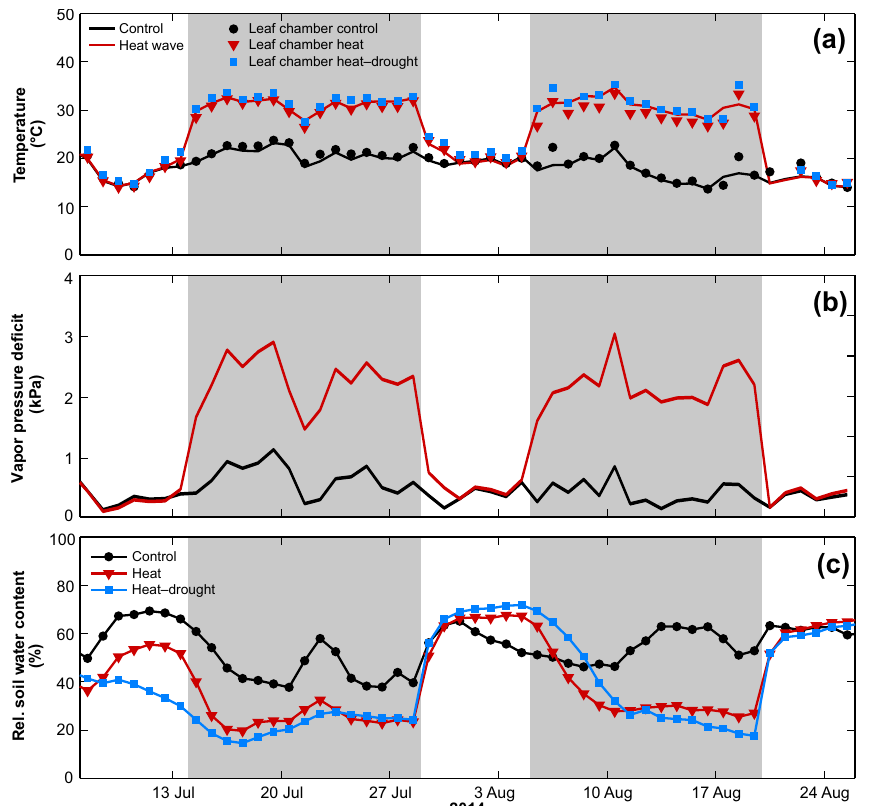
Figure 2. Daily average temperatures (a) in the control (black line) and stress (red line) compartments of the greenhouse and in the plant chambers of the control (black circles), heat (red triangles) and heat–drought (blue squares) treatments. Daily average vapor pressure deficit (b) in the control (black line) and heat (red line) compartment of the greenhouse and relative soil water content (c) averaged for each treatment (control – black line and symbol, heat – red line and symbol, heat–drought – blue line and symbol) and measurement day. Heatwaves are represented by the grey colored